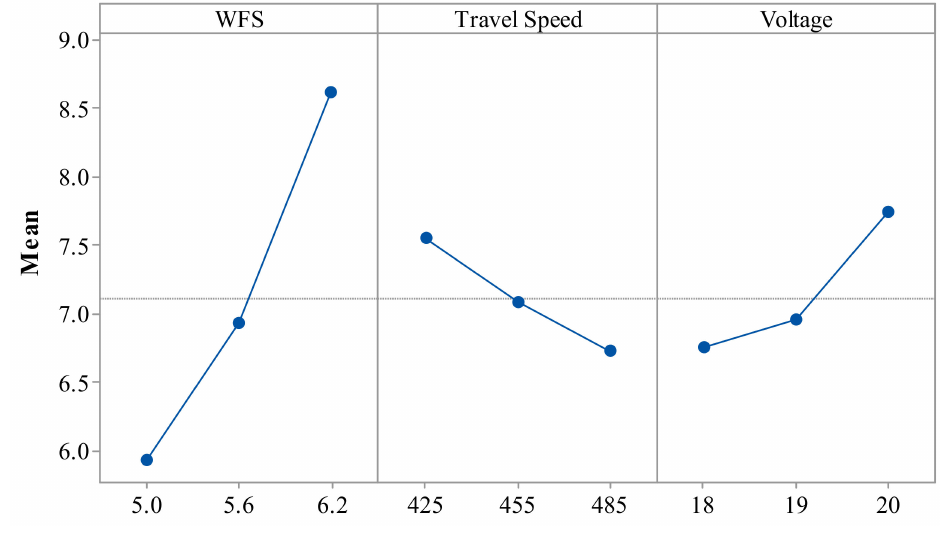
Figure 4. Main effect plot for BW.